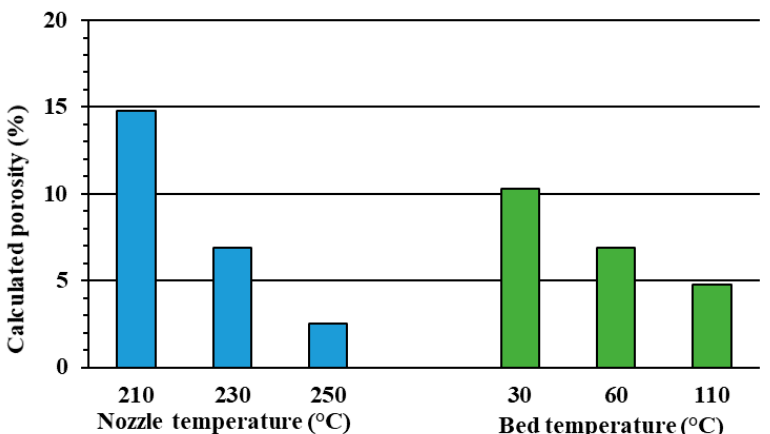
Figure 14. Calculated porosity of the printed samples at different nozzle and bed temperatures using X-ray microtomography.